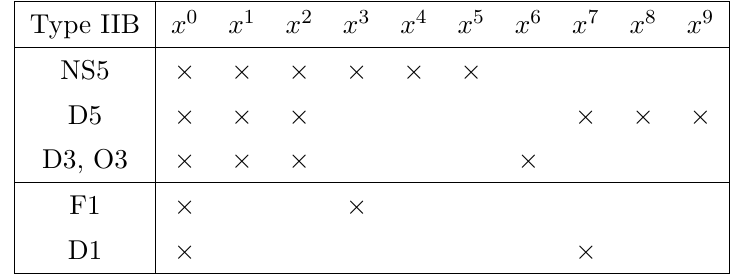
Table 2 . Occupation of space-time directions by NS5, D5, D3, and O3 in Type IIB. The funda- mental string F1 induces the electric theory, while the D-string D1 induces the magnetic theory.